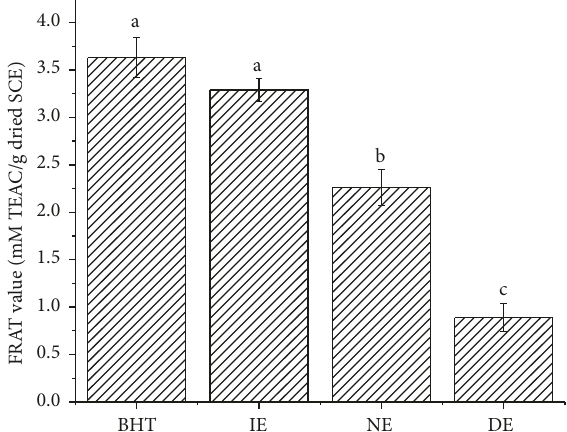
Figure2:TheFRAPvaluesofcamelliaoilcakephenolicextractsand BHT on corn oil (BHT, butylated hydroxytoluene; IE, isopropanol extract;NE,normalhexaneextract;DE,diethyletherextract;TEAC, Trolox equivalent antioxidant capacity). The data are averages and standard deviations of triplicate measurements. Values in each bar with different superscript letters (a, b, c) are significantly different ( 𝑝 < 0.05